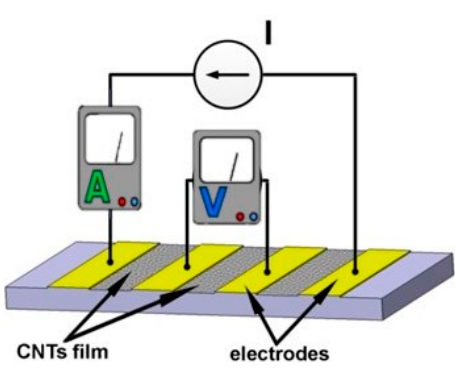
Figure 10. Measurement setup for a temperature sensor based on freestanding CNTs thin film.